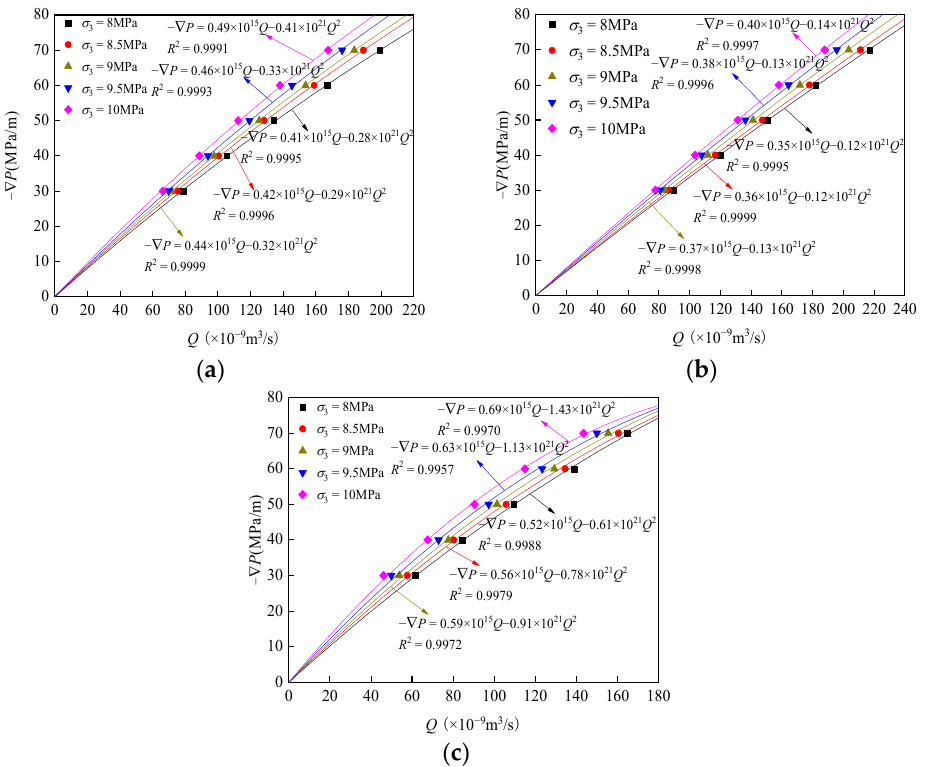
Forchheimer equation is applicable to accurate prediction of water gushing in under ‐ ground projects such as mining and tunnels.